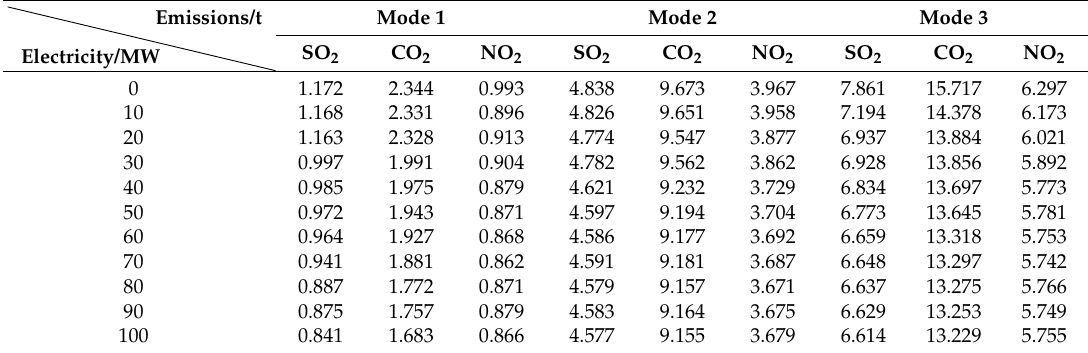
Table 9. Comparison of pollutant emissions under different scheduling models.